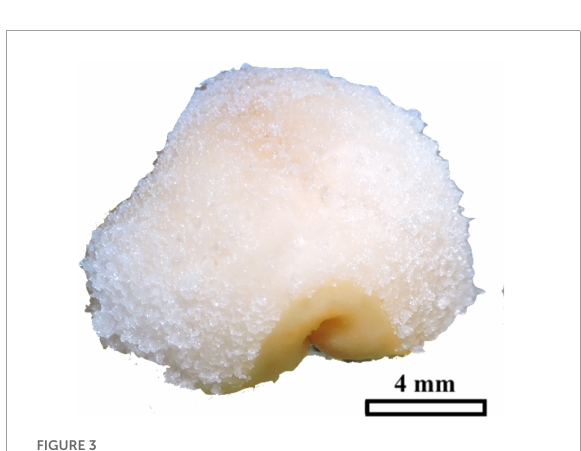
FIGURE3 Peach palm primary callus formed on swollen TCLs, consisting of white and fibrous tissues. The black bar scale equivalent to 4